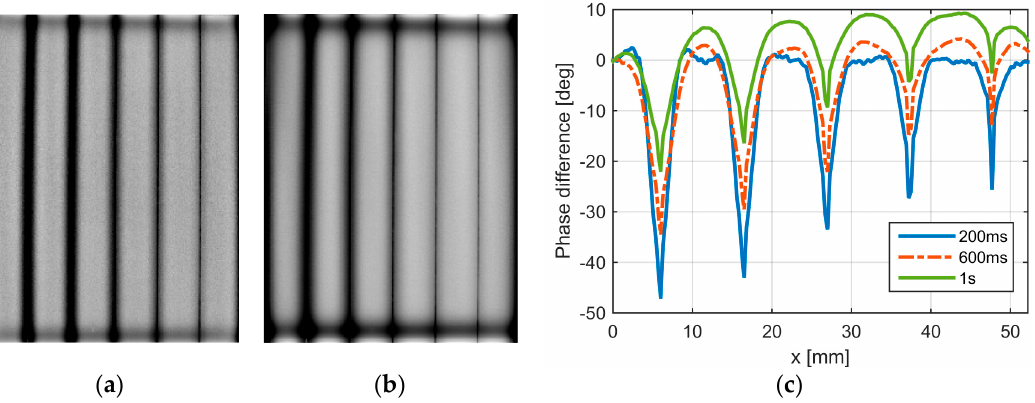
Figure 26. Phase images for a non-magnetic steel sample with five artificial defects, with 2, 1.5, 1, 0.75, and 0.5 mm depths, from left to right, respectively. ( a ) t pulse = 0.2 s; ( b ) t pulse = 0.6 s; ( c ) profiles through the phase images for different heating pulses.